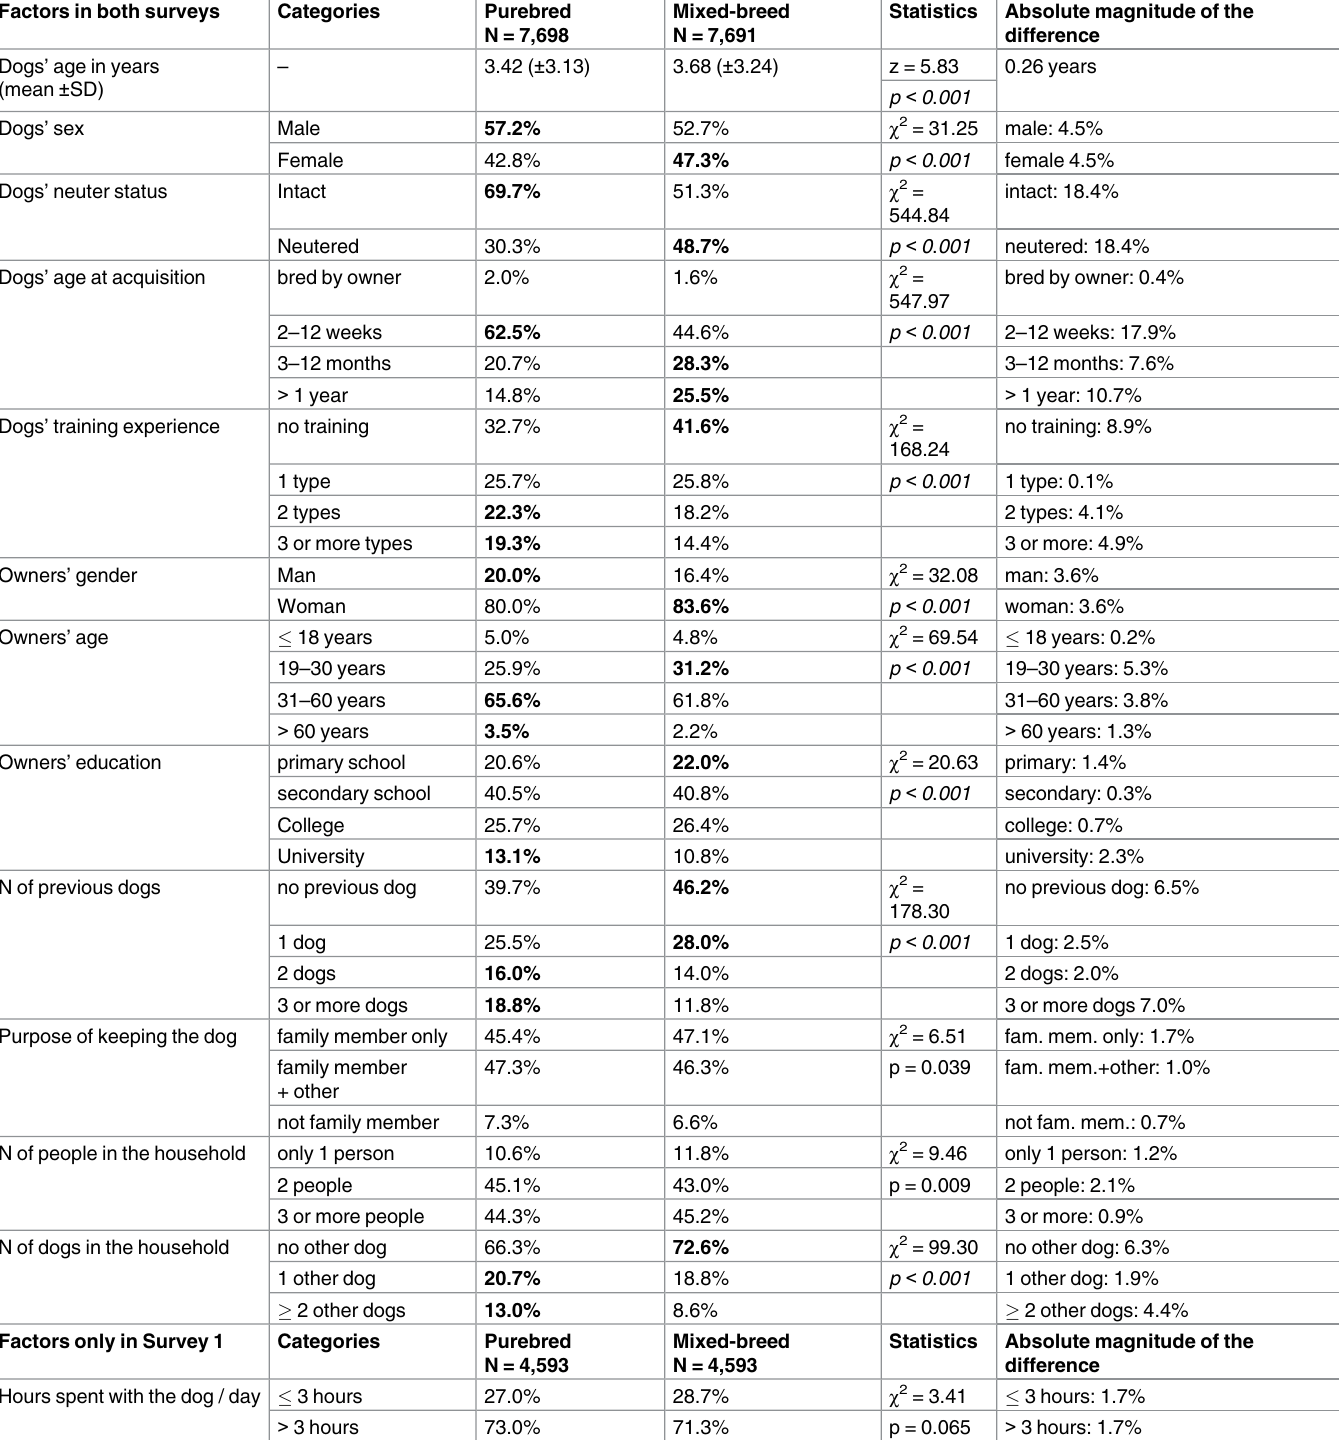
Table 2. Comparison of demographic and dog keeping factors between purebred and mixed-breed dogs. Factors in both